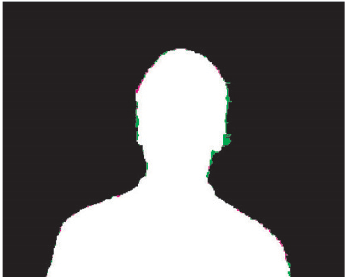
Figure 14: The colored segmentation result of frame 15 from the sequence “Erik,” segmented using COST AM 5.1.